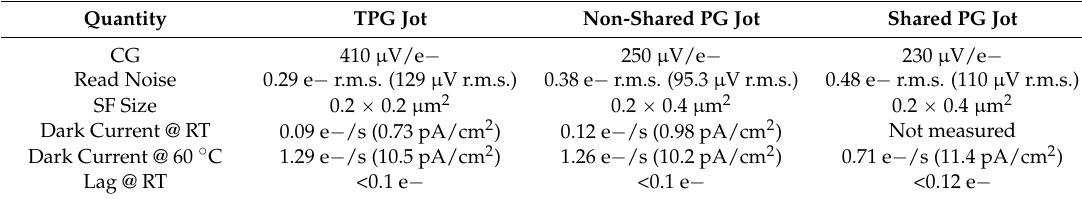
Table 1. Summary of characterization results of PG jot devices.